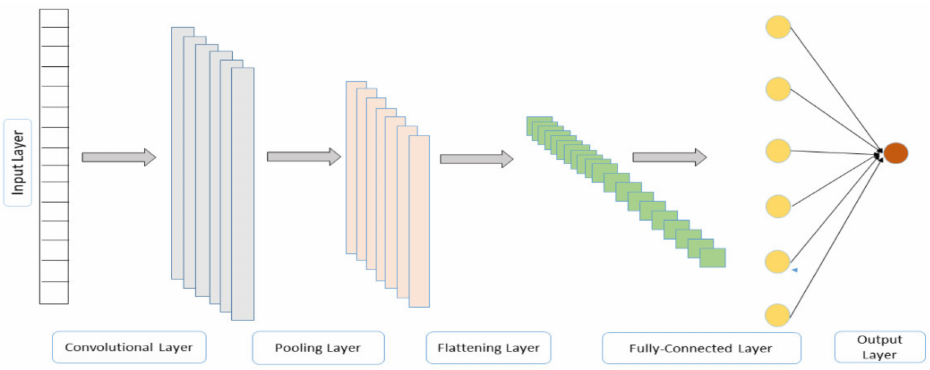
Figure 3. Representation of a